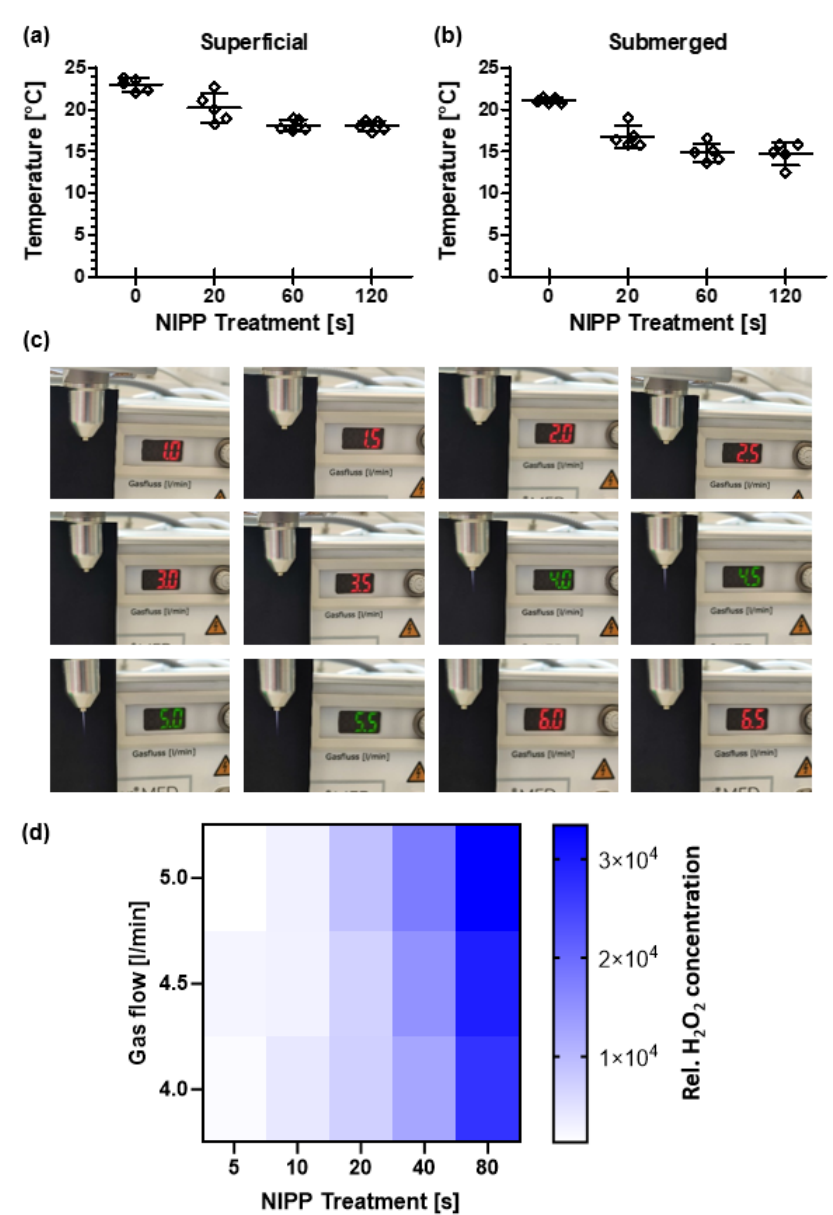
Figure 3. Basic NIPP characterization. ( a ) Superficial (FLIR One infrared camera, Teledyne Flir) and ( b ) submerged (Lab Thermometer IP65 with an LT-101 temperature sensor, TFA Dostmann) temperature variations of cell culture medium at room temperature during 120 s of NIPP treatment. ( c ) Flame pattern after ignition of the NIPP flame at carrier gas flow rates from 1.0 to 6.5 L/min. The flow rates are shown in the device’s own display. ( d ) H 2 O 2 formation after NIPP treatment. Ultrapure water was treated with NIPP at flow rates of 4.0, 4.5, and 5.0 L/min and treatment durations of 5 to 80 s. The relative H 2 O 2 concentrations were determined by a Molecular Probes Amplex Red Hydrogen Peroxide/Peroxidase Assay Kit (Thermo Fisher